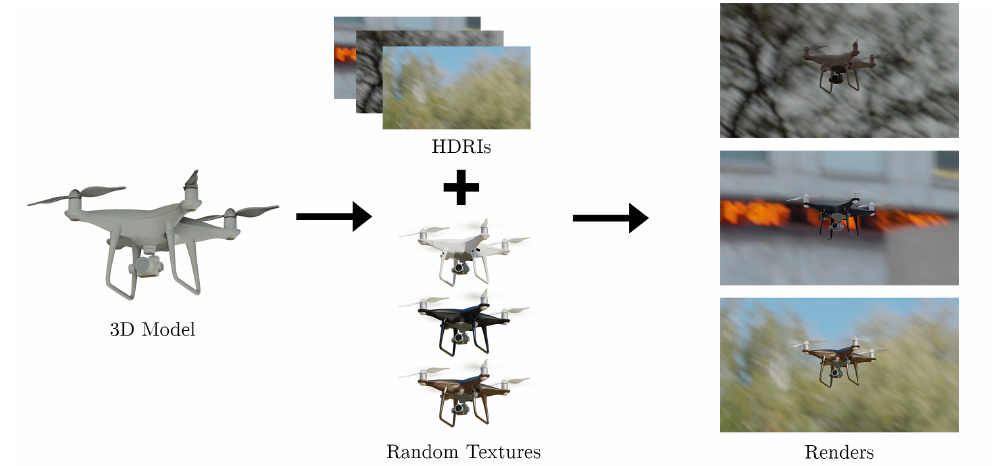
Figure 1. Process of rendering a synthetic drone. A 3D model of the drone is required and in this example we show a DJI Phantom. Random textures are applied to the 3D model. A high dynamic range image (HDRI) containing a realistic lighting setup is set as the background scene. The drone is rendered using the Cycles engine in Blender.